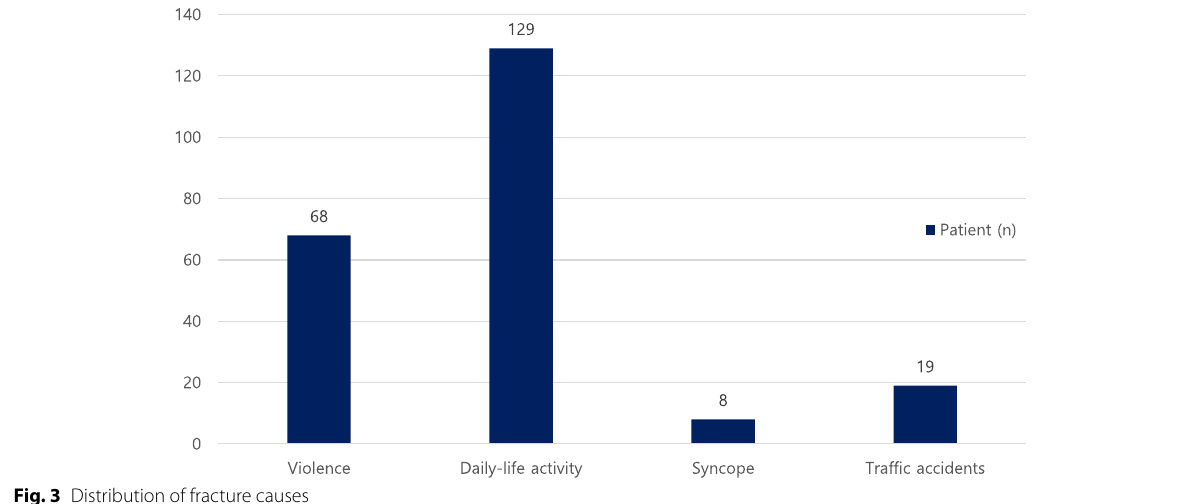
Fig. 3 Distribution of fracture